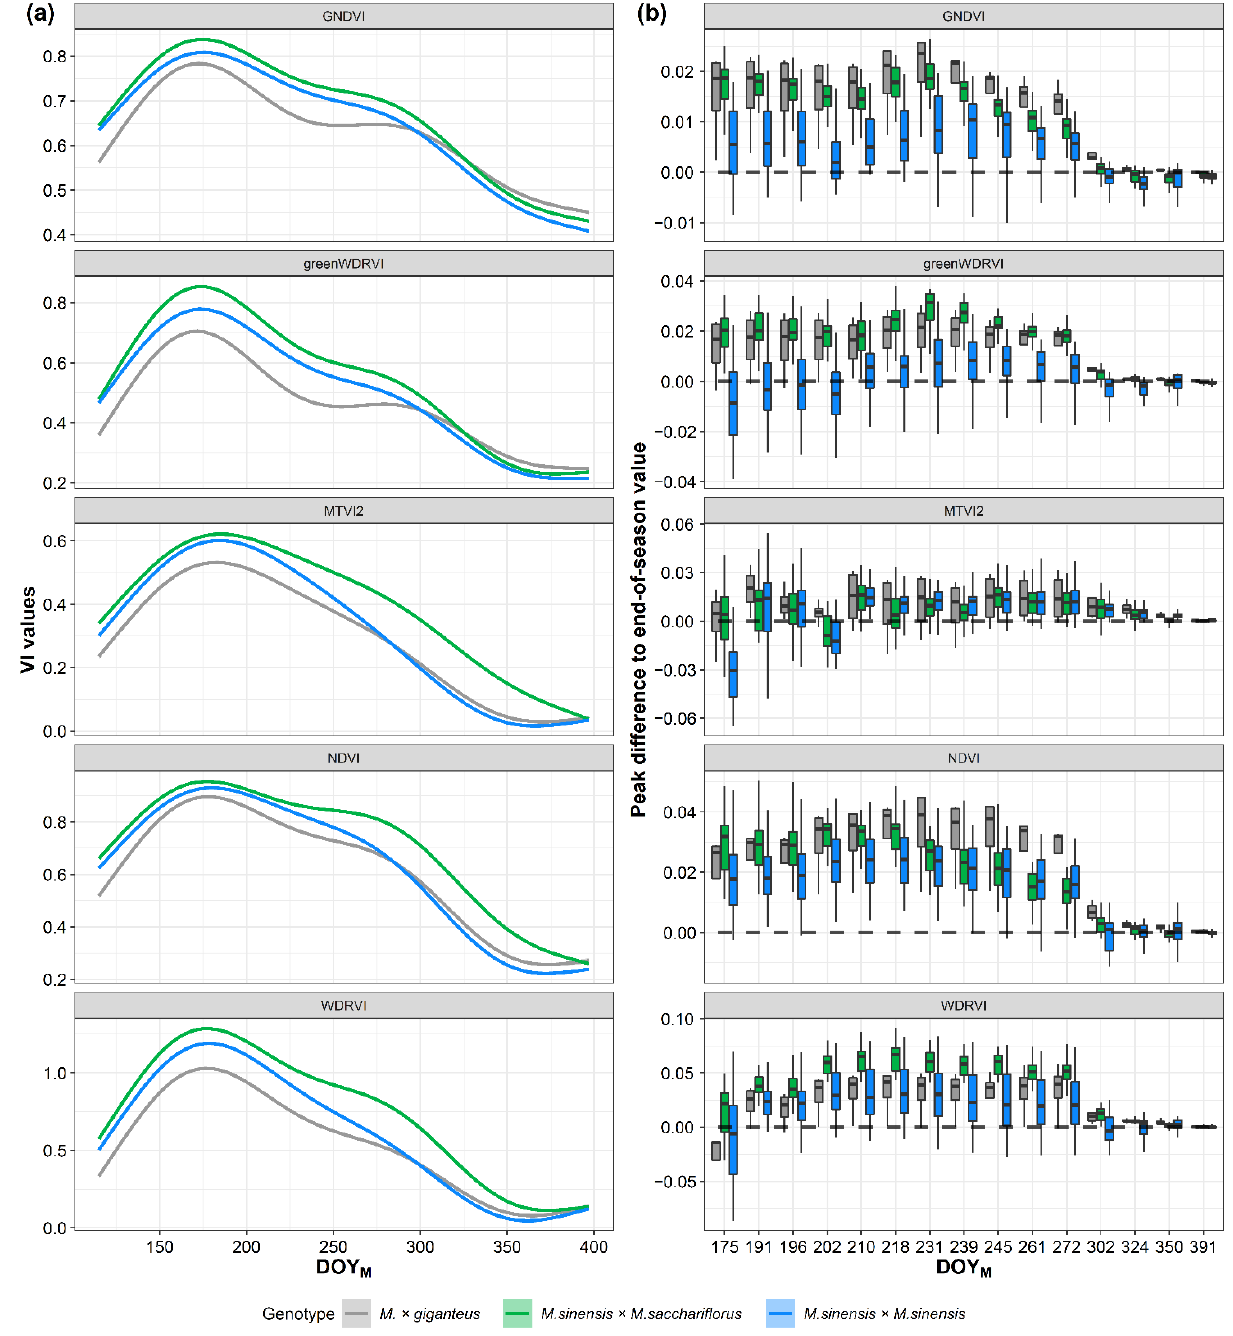
Figure 9. ( a ) Time series of the five VIs (GNDVI, greenWDRVI, MTVI2, NDVI, and WDRVI) fitted via the generalized additive model (GAM) throughout the growing season of Miscanthus in PAC 1. Modified days of the year (DOY M ) were calculated by adding 365 to the DOY of the corresponding year from January on. ( b ) Variation of the peak of the VIs derived from the complete time series of the VIs as compared to the peak of the VIs derived from the partial time series of the VIs. The DOY M of the UAV flights performed during the season in PAC 1 are reported in the x-axis. In the y-axis, the peak differences between the peak derived to the end of the season in PAC 1 (397 DOY M ) and the peak derived from partial time series fitted until the DOY M of the UAV flight, are reported.